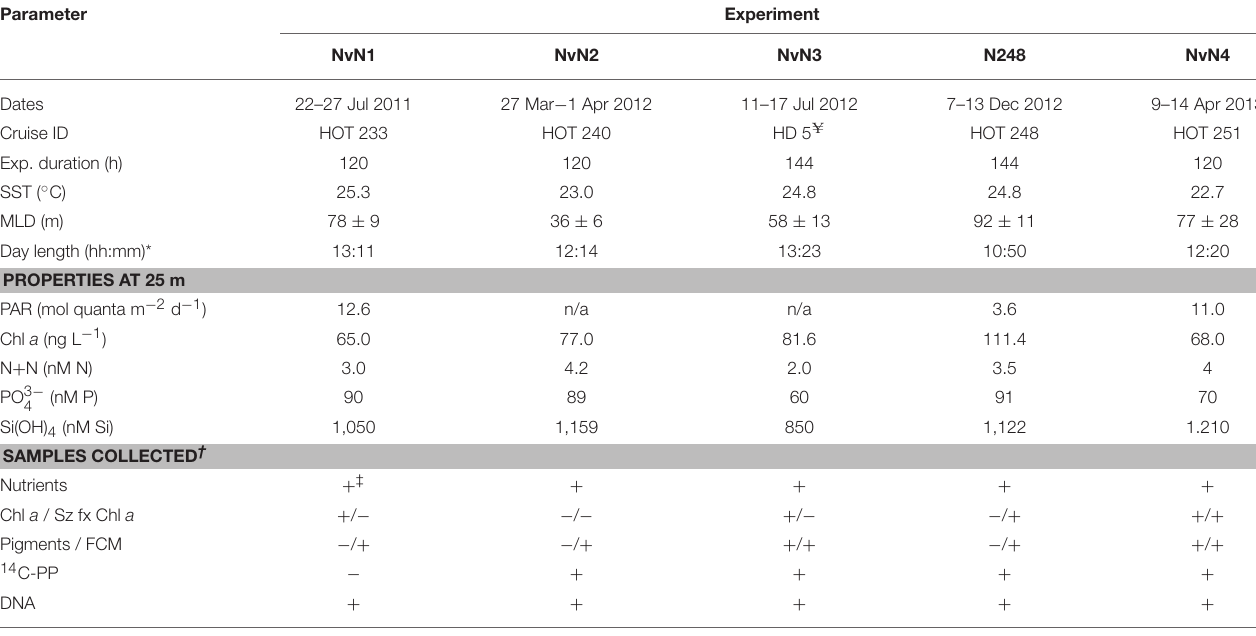
TABLE 1 | Dates, cruise ID, duration, sea surface temperature (SST), mixed layer depth (MLD), and day length when each experiment was conducted. Parameter Experiment